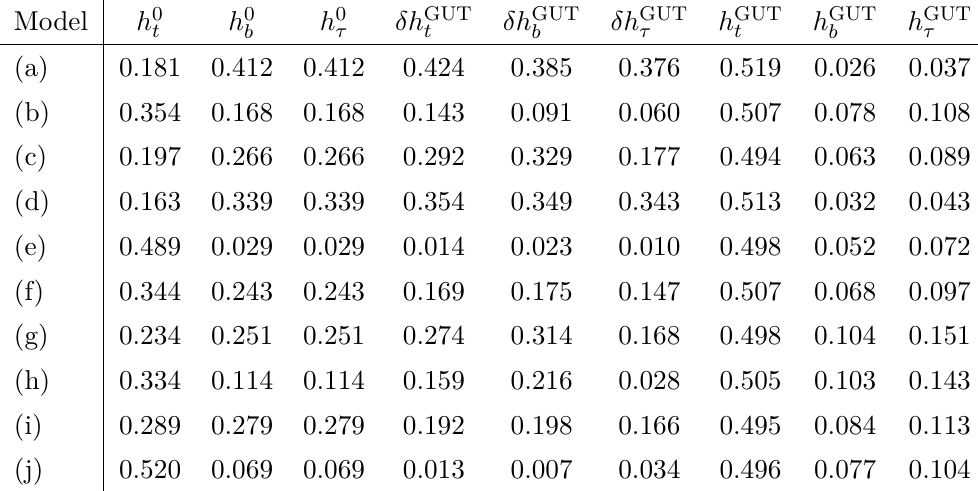
Table 5 . The magnitude of the contributions to the top, bottom, and tau Yukawa couplings from cubic interactions (columns 2-4), from quartic interactions (columns 5-7) and the magnitude of their complex sum (columns 8-10) at the GUT scale for the parameter set of table 4. The Yukawa couplings are in general complex and we add the contributions of the cubic and quartic interactions as complex numbers and exhibit only their magnitudes in the